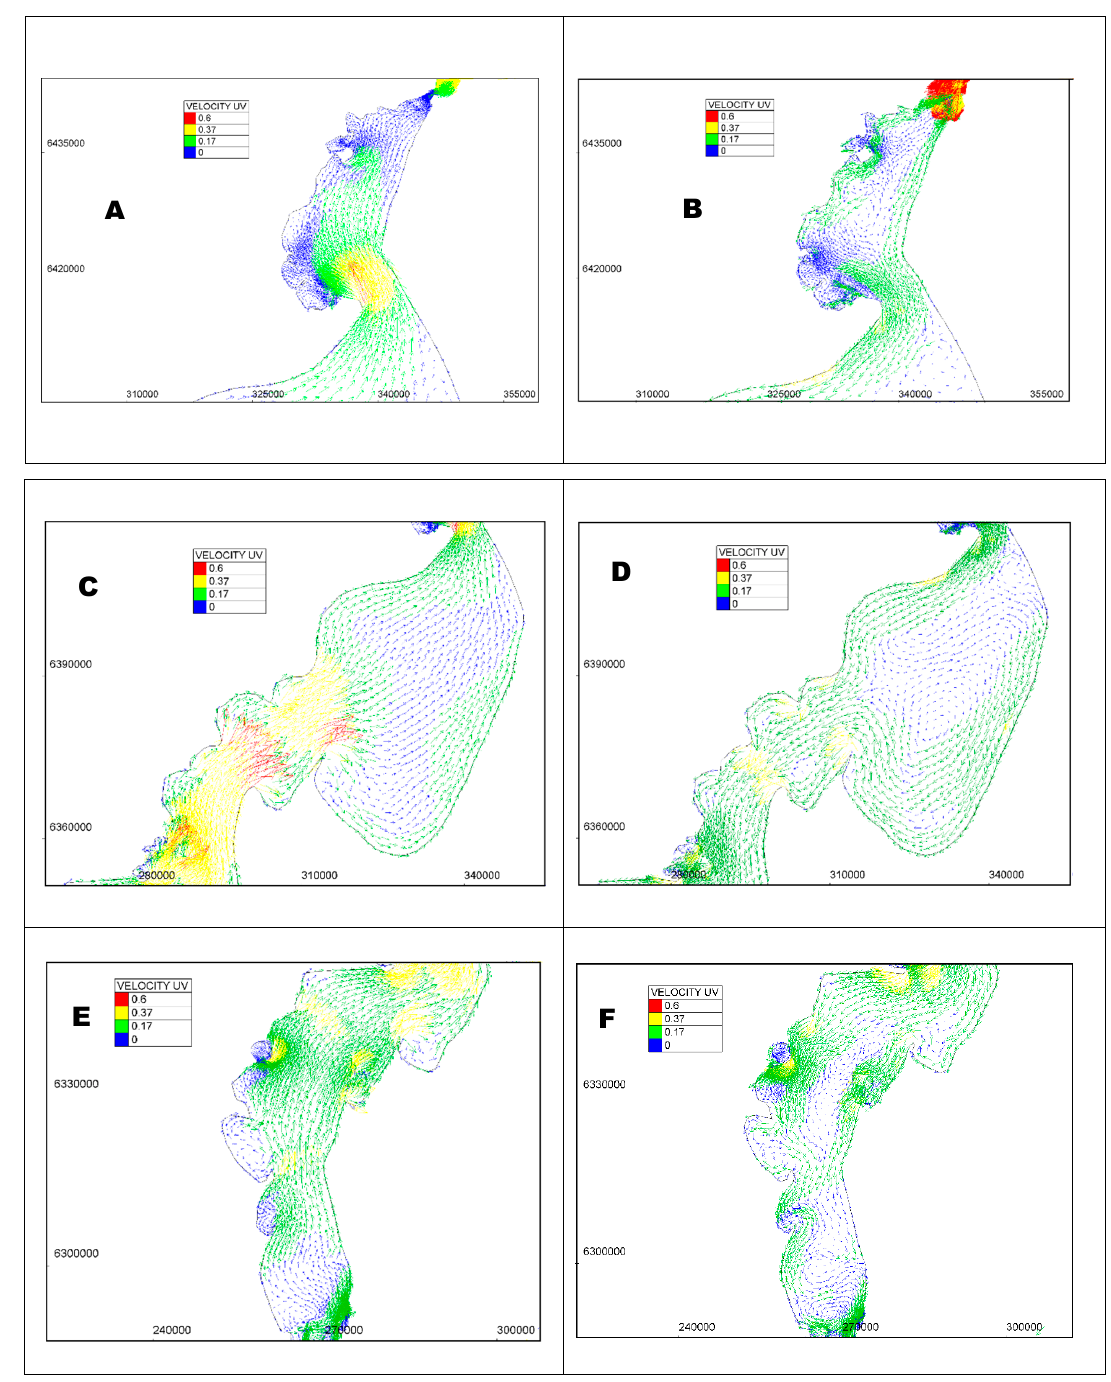
Figure 9. Calculated surface current velocity vectors at different Mirim lagoon regions for the maximum southwestern wind ( A , C , and E ) and maximum northeastern wind ( B , D , and F ) observed during the simulation period.